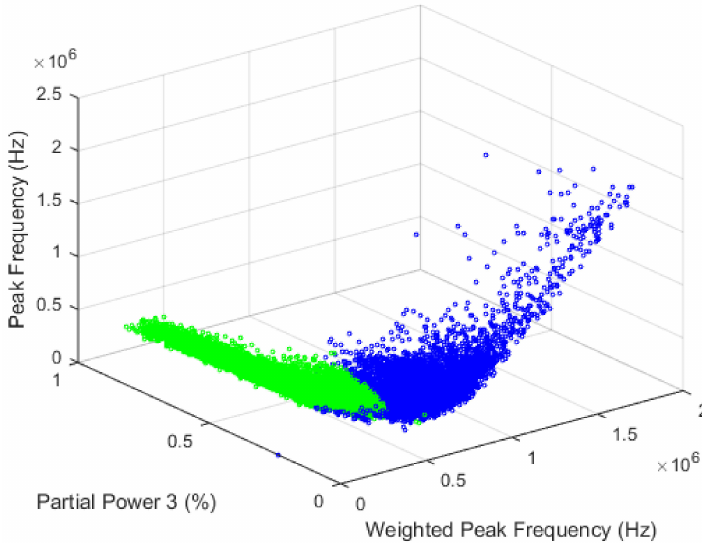
Figure 9. Results of clustering algorithms and the clusters in feature